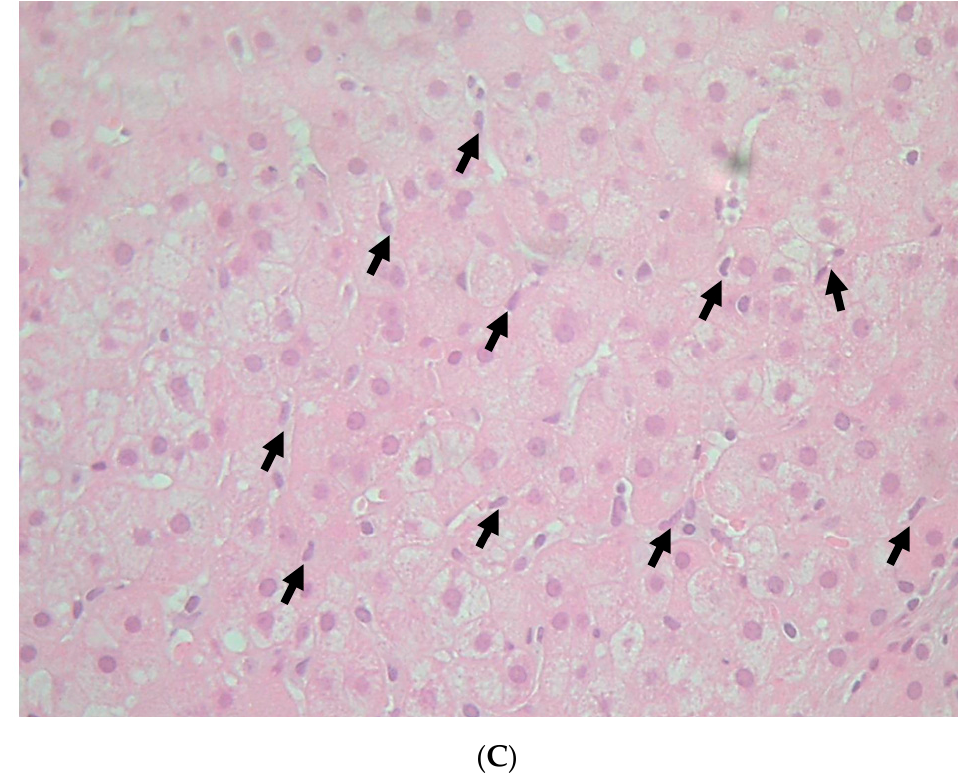
Figure 3. Pathology of liver biopsy (Case 2) at 3.0 months after stereotactic body radiotherapy (SBRT). ( A ) × 10 silver impregnation stain; HCC and background liver. From the liver tissue histology of the sinusoidal wall in the stain pattern, it was judged whether it was the liver that received radiation with the liver tissue histology of silver impregnation stain pattern of the sinusoidal wall. Background liver tissue fragment (right) and HCC fragment (left). ( B ) × 20 Hematoxylin and eosin staining; HCC sniped biopsy. Background liver tissue fragment (right) and HCC fragment (left). Both fragments received radiation. ( C ) × 40 hematoxylin and eosin staining; non-radiation liver tissue, as a control liver tissue. There are many endothelial cells (black arrows) in the sinusoids. Silver impregnation staining showed atrophy and the disappearance of hepatocyte (Figure 4A). In the case of surgical material (Case 3, 4M), close to the HCC nodule, there was disappearance of liver parenchyma (hepatocytes and endothelium), so portal tracts came close (Figure 4A). The area was slightly beyond the HCC nodule. The radiation effect on the endothelium appeared rough, indicating degeneration (Figure 4B). Some parts of the endothelium disappeared, and the sinusoid was enlarged (Figure 4B). In the portal tract, the portal vein disappeared and the arteriole increased (Figure